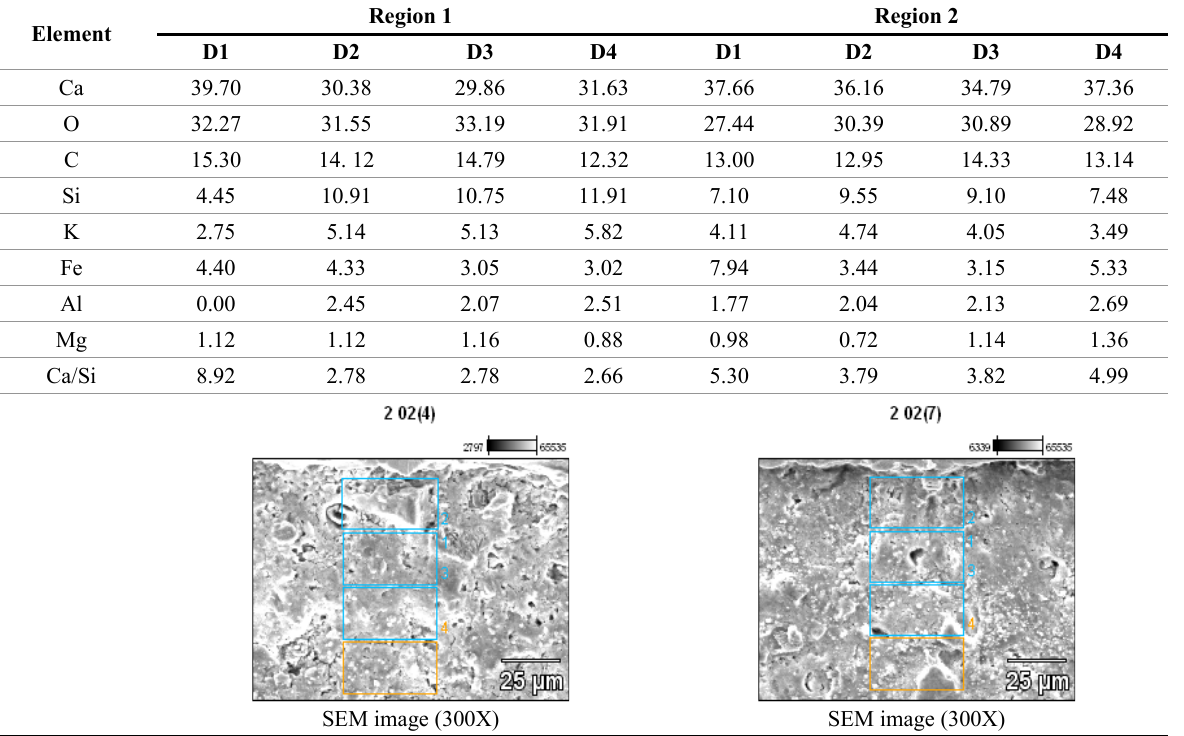
Table 3. Chemical composition at the steel microfiber-cementitious matrix interface. Element